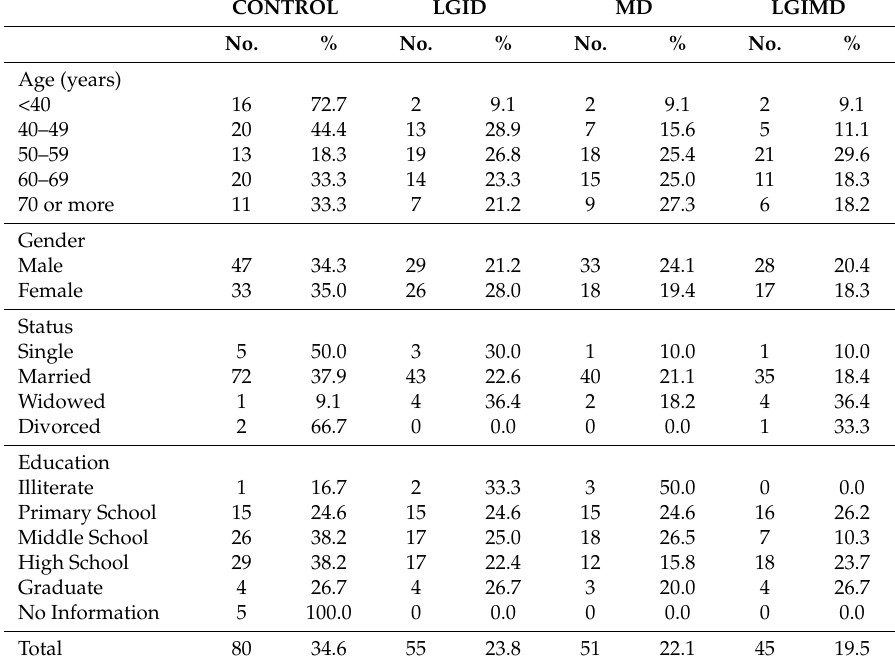
Table 1 . Socio-demographic Characteristics of Participants. Table 1. Socio-demographic Characteristics of Participants.